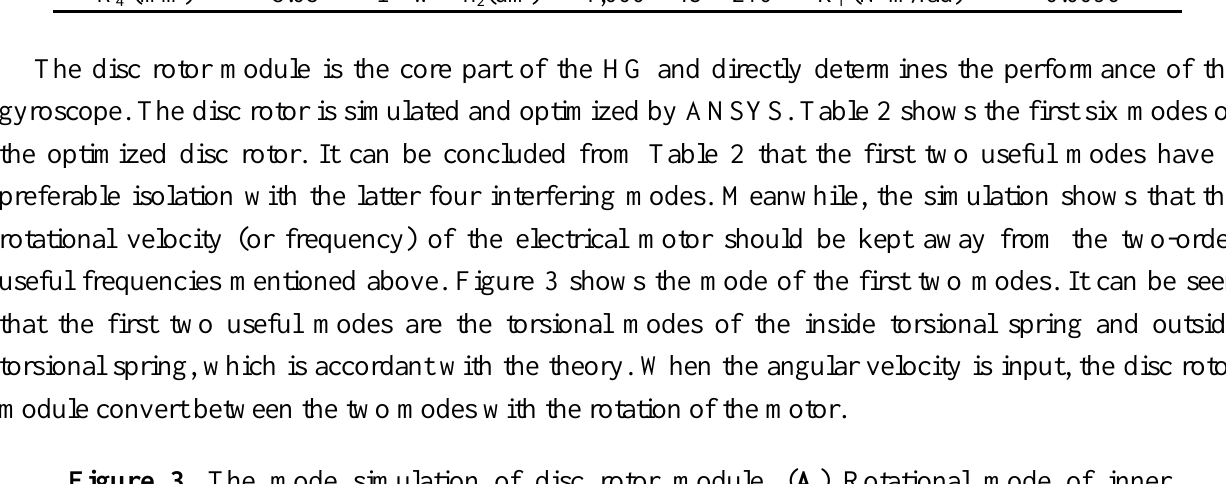
Figure 3. The mode simulation of disc rotor module. ( A ) Rotational mode of inner torsional spring. ( B ) Rotational mode of outer torsional spring.